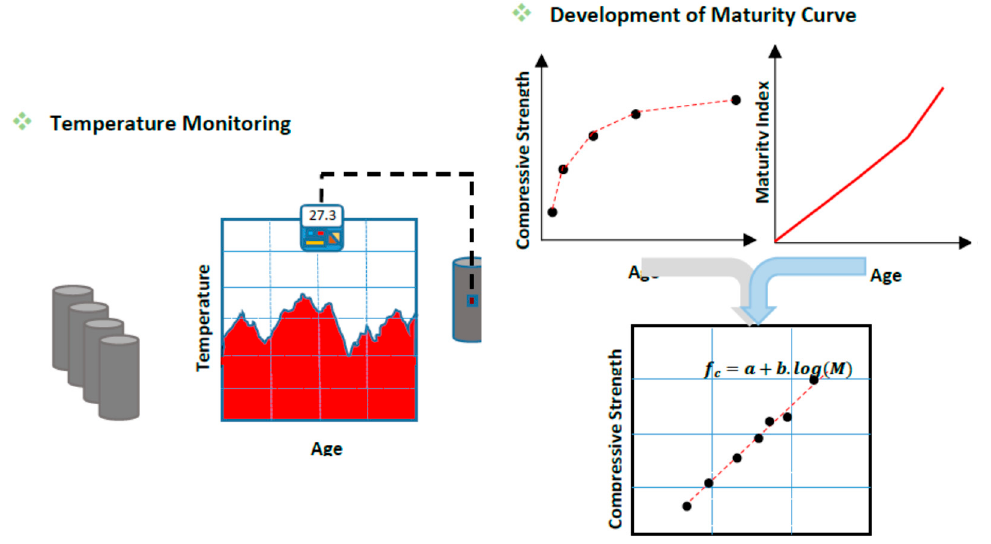
Figure 4. Schematic procedure of temperature history monitoring, maturity index, and compressive strength in the concrete maturity method.